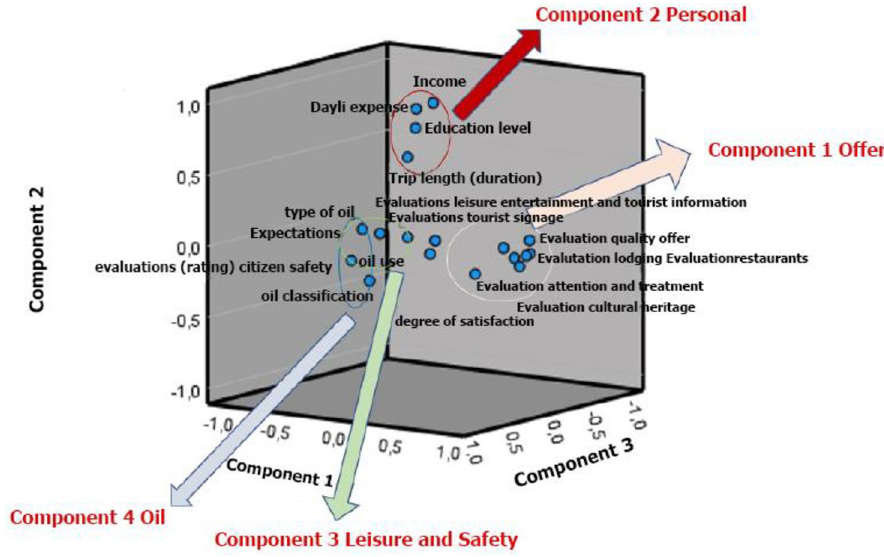
Fig 6. Component plot in rotated